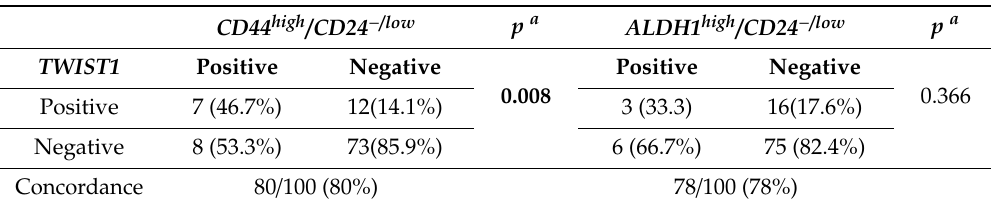
Table 1. Correlation between TWIST1 and CD44 high / CD24 − / low and ALDH1 high / CD24 − / low expression in early breast cancer EpCAM positive samples ( n =